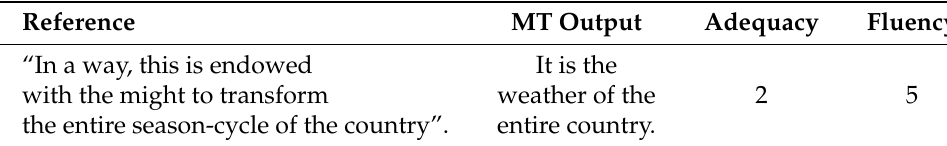
Table 5. An example of unconsidered translation for Hindi-to-English.